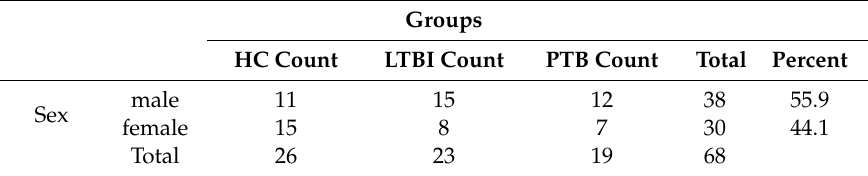
Table 2. Participants’ disease categories and sex distribution.